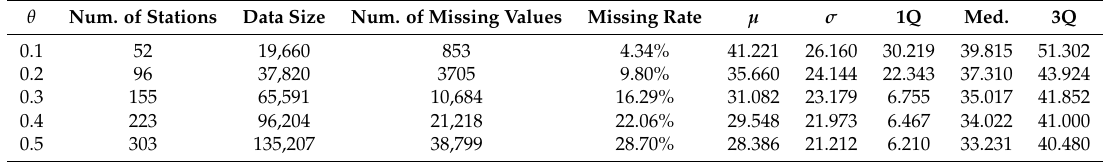
Table 3. Summary of the training set.